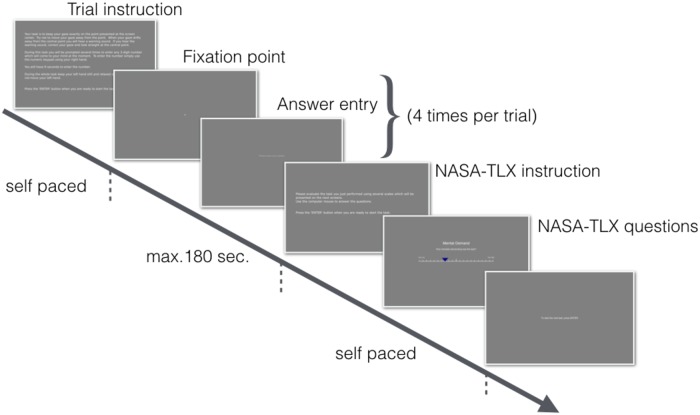
Time course of each experimental trial.Note that because we wanted to present the experimental procedure as accurately as possible the fixation point and text entry text are hardly visible on this figure due to its size. In the actual experimental settings both were clearly visible for participants on the computer screen. The actual fixation point was defined as a circle with radius of 5 pixels and color defined as [0.2,0.2,0.2] in the RGB color scale. That color can be described as an increment of 0.2 above the gray background. Note that each value in the RGB space in PsychoPy is defined by the range between -1 and 1. The same color was applied to the text on the “Answer entry” screen.